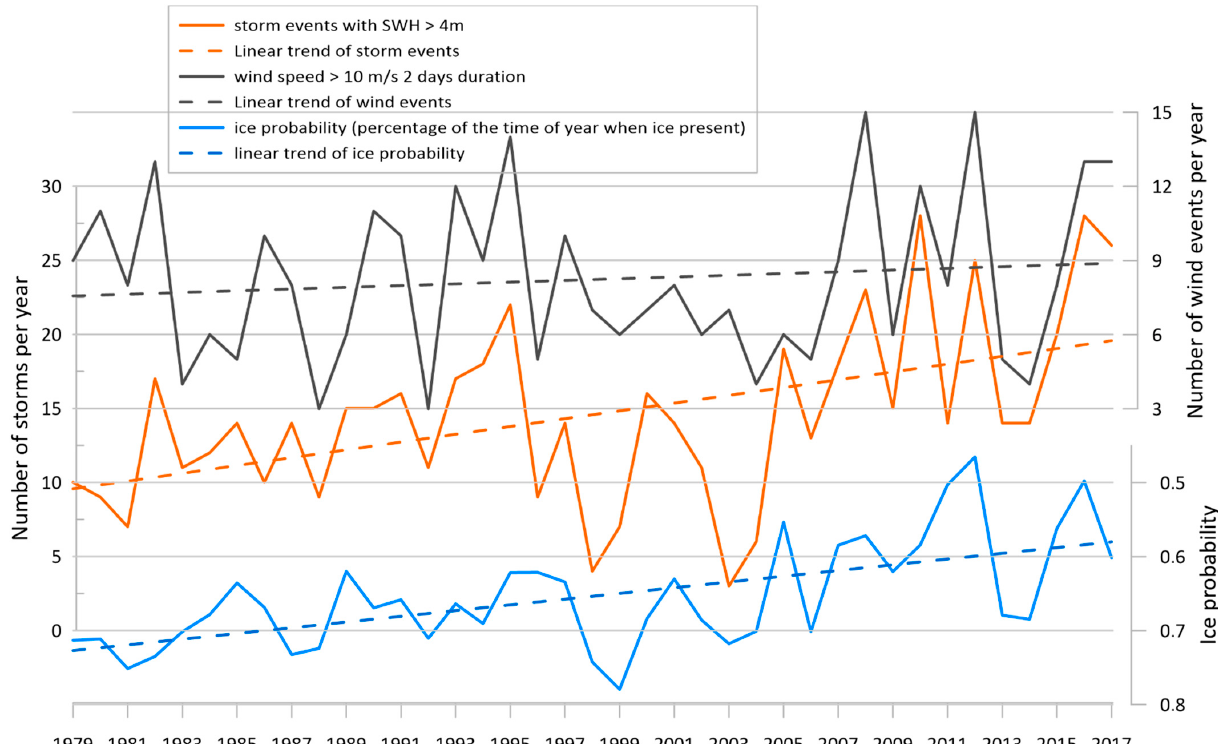
Figure 12. Recurrence of wind speed of more than 10 m/s and 2 consecutive days at T1 point, the number of storms with a SWH threshold 4 m, and probability of the ice presence at T1 point (opposite scale).